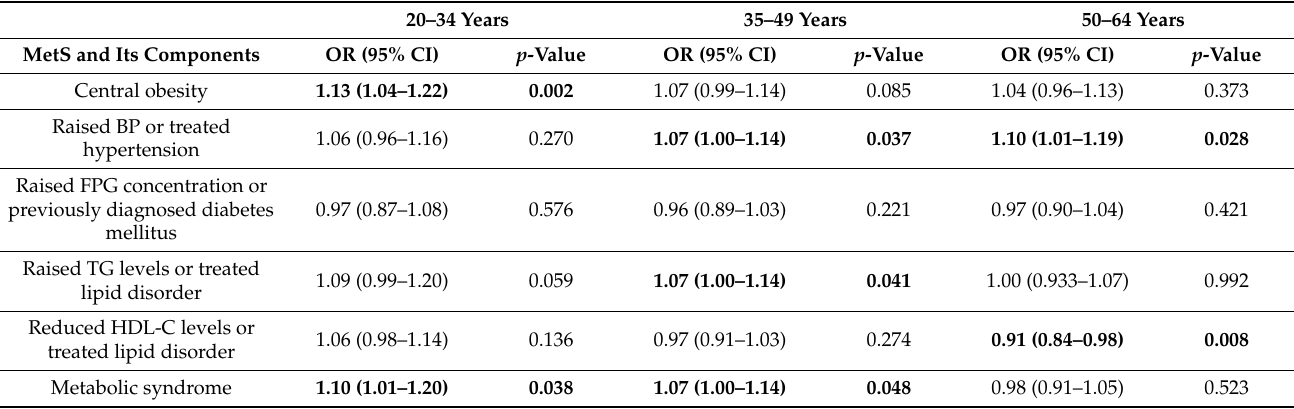
Table 2. The results of multivariate logistic regression models (adjusted by age and sex) estimating the risk for metabolic syndrome and its components in the Roma samples from 2018 compared to those from 2011 by age